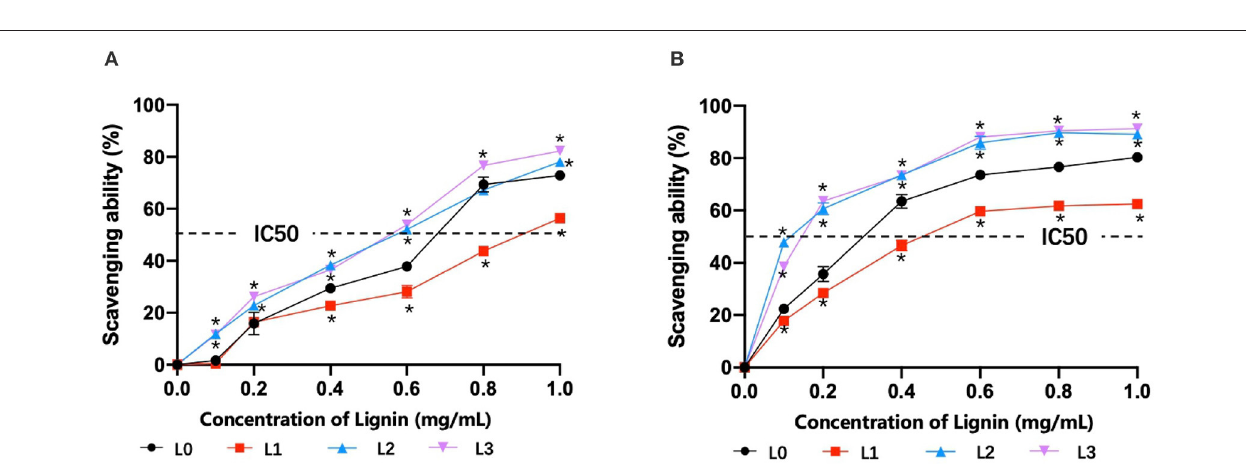
filtration and organosolv fractionation were directly related to their molecular weight. In the work of Yang et al. (2018), the antioxidant and antimicrobial capacities of lignin were found to be related to the phenolic hydroxyl group in the lignin structure. Hence, it was speculated that the obtained lignin fraction of L3 with the highest amount of phenolic hydroxyl content might have the best biological activity.